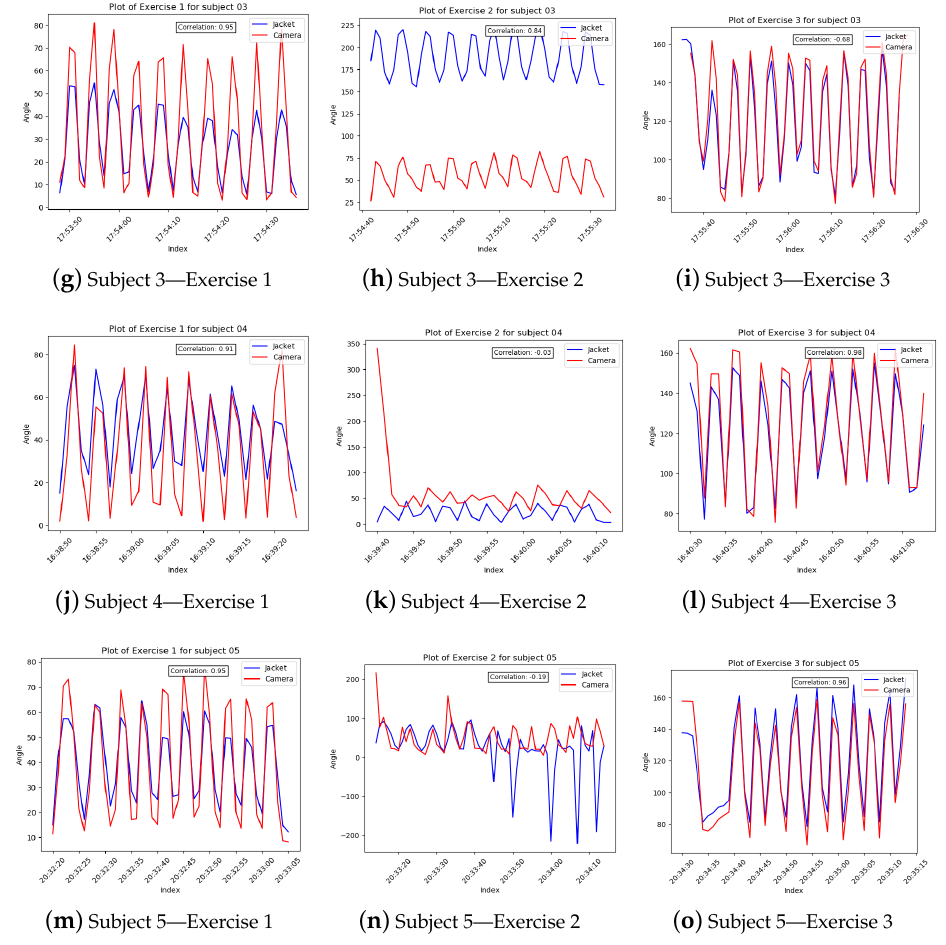
Figure 4. Robotic Jacket Validation Experiment Results for subjects 1 through 5. The camera angle measurements (red) are overlaid with the wearable jacket-generated inertial sensor approximation (blue) over time.